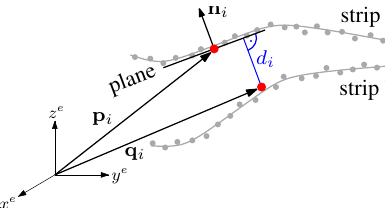
Figure 5: The point-to-plane distance d i for the i -th correspon- dence is defined as the perpendicular distance from point q i to the tangent plane defined by p i and n i . The point q i is the nearest neighbour of the point p i